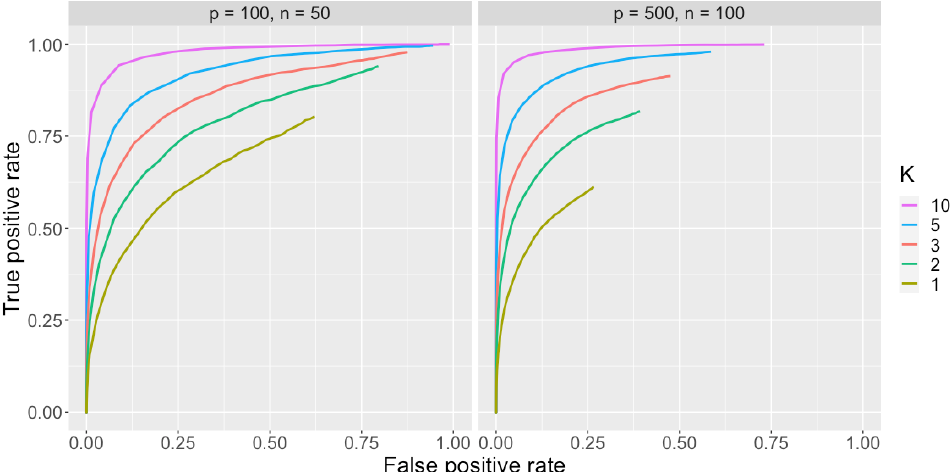
Figure 1. ROC-curve for jewel method applied to the different number of datasets K (denoted by different colors). Left panel : performance for p = 100, n k = 50 ∀ k . Right panel : performance for p = 500, n k = 100 ∀ k